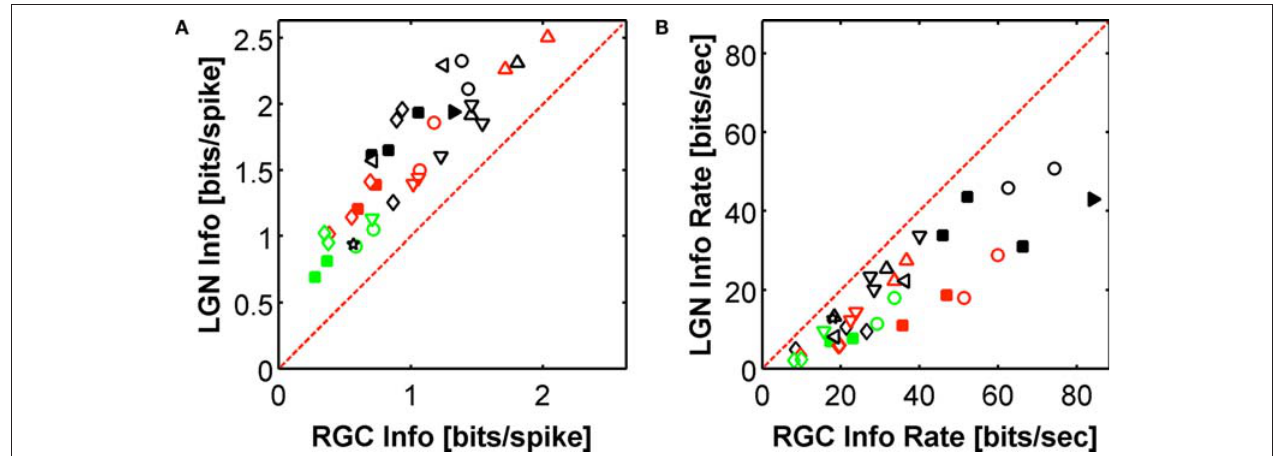
FIGURE 3 | Relation between single spike information in LGN and RGC. close (within 5 bits/s). A distinct difference in the information rate between small (A) Information I in units of bits per spike (for various cell-spot size and large spot sizes is apparent. Distinct symbols (used also in Table 1 ) represent spike combinations). All the points are above the line of unit slope, indicating that the different cells, and the colors represent stimulus sizes, in units of multiples of RF LGN spike train is more effi cient (contains more information per spike) than the center diameter (see Materials and Methods): ≤ 1.5 centers (black), 1.5 < SS ≤ 3 corresponding input RGC train. (B) Information rate (in bits per second). The red centers (red), SS > 3 centers (green). X ON and X OFF cells are denoted by fi lled dashed line represents points for which the LGN information rate matches that of and open symbols, respectively. The error bars on the data points (in both the RGC. While none of the points are found on this line, 29% of them lie very directions) are smaller than the symbols themselves and are not shown.